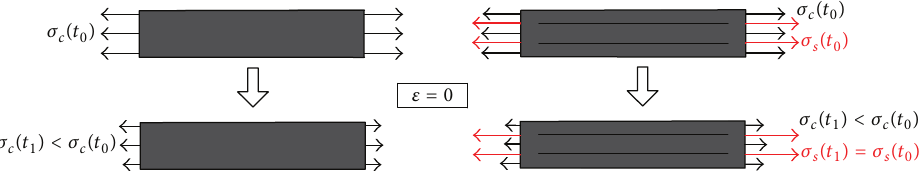
Figure 3: Effect of reinforcement on concrete stress in relaxation tests ( 𝜎 𝑐 : concrete stress; 𝜎 𝑠 : reinforcement stress).